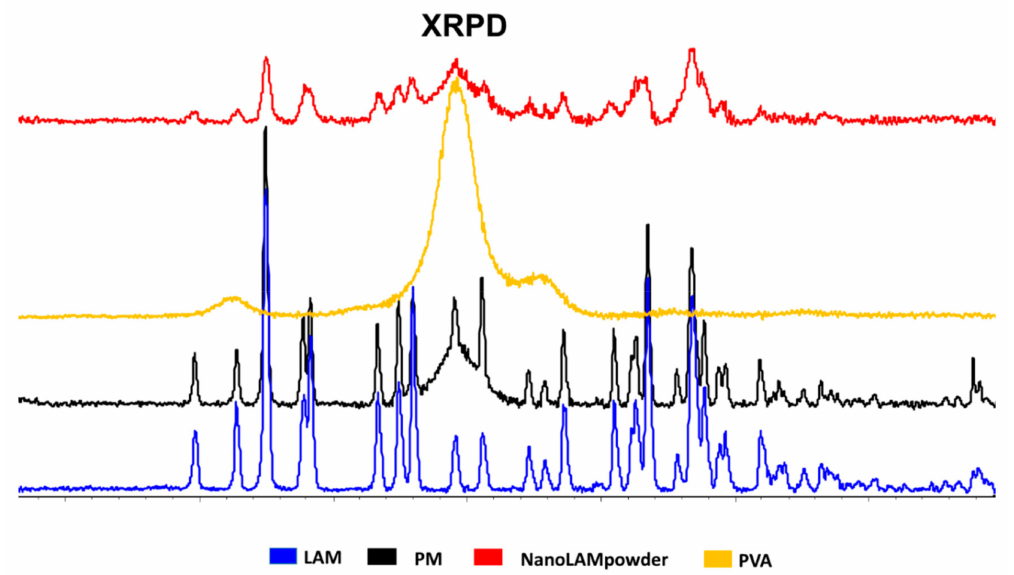
Figure 3. XRPD di ff ractograms of the